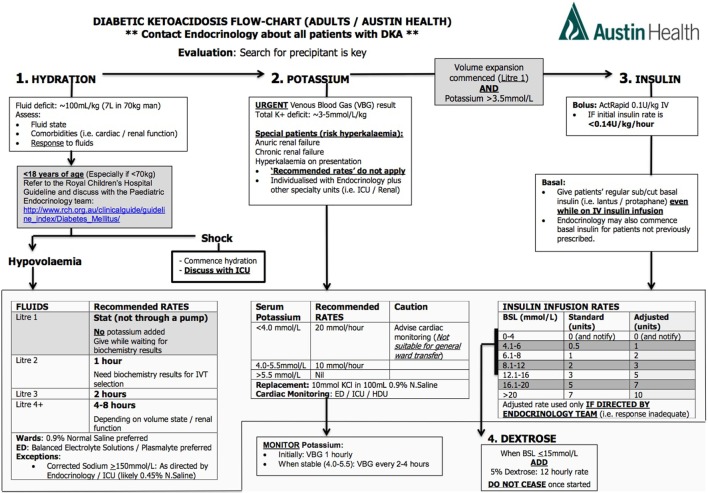
Protocol for management of diabetic ketoacidosis at our centre.